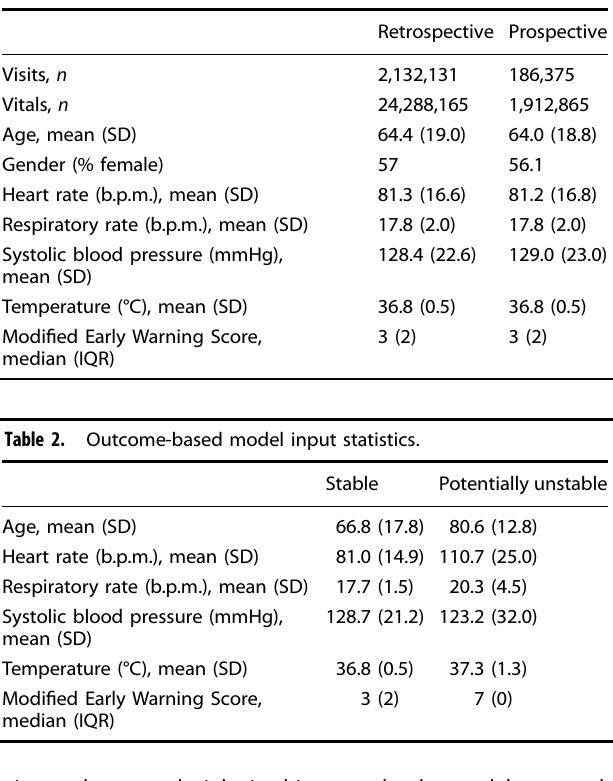
Table 1. Data summary statistics.